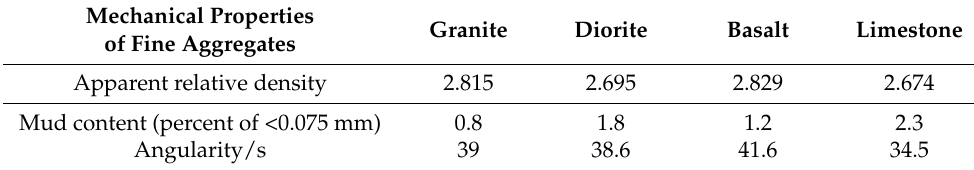
Table 3. Physical properties of used fine aggregates.